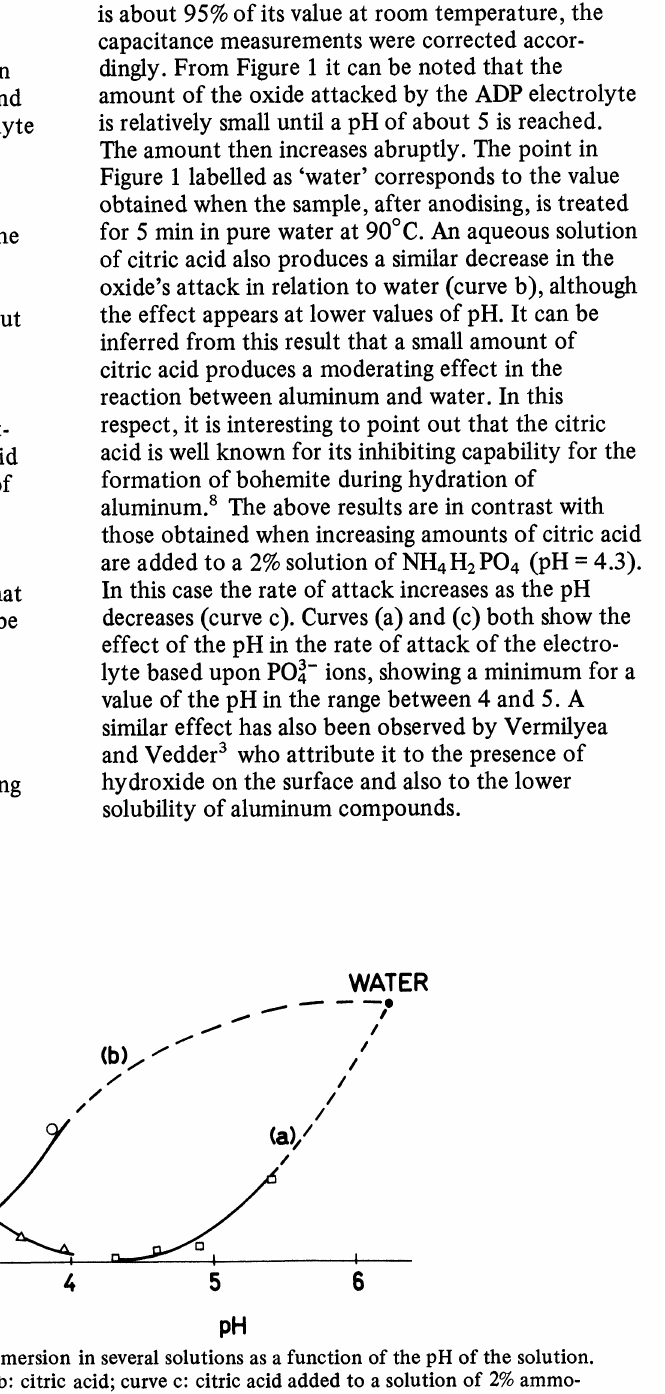
Fraction of attacked oxide during immersion in several solutions as a function of the pH of the solution. Curve a: ammonium dihydrogen phosphate; curve 19" citric acid; curve c" citric acid added to a solution of 2% ammo- nium dihydrogen phosphate in